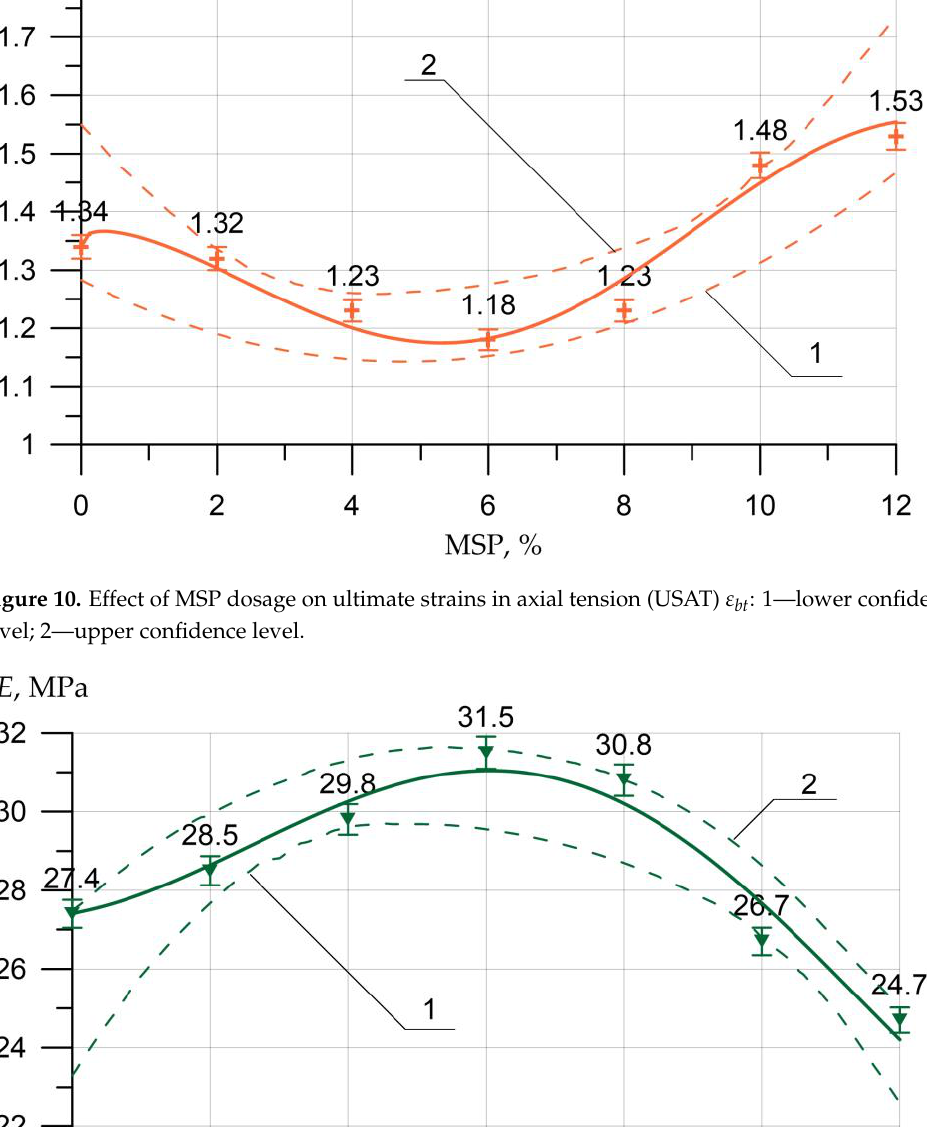
Figure 11. Dependence of the ME of concrete on the amount of MSP: 1‒lower confidence level; 2– upper confidence level.